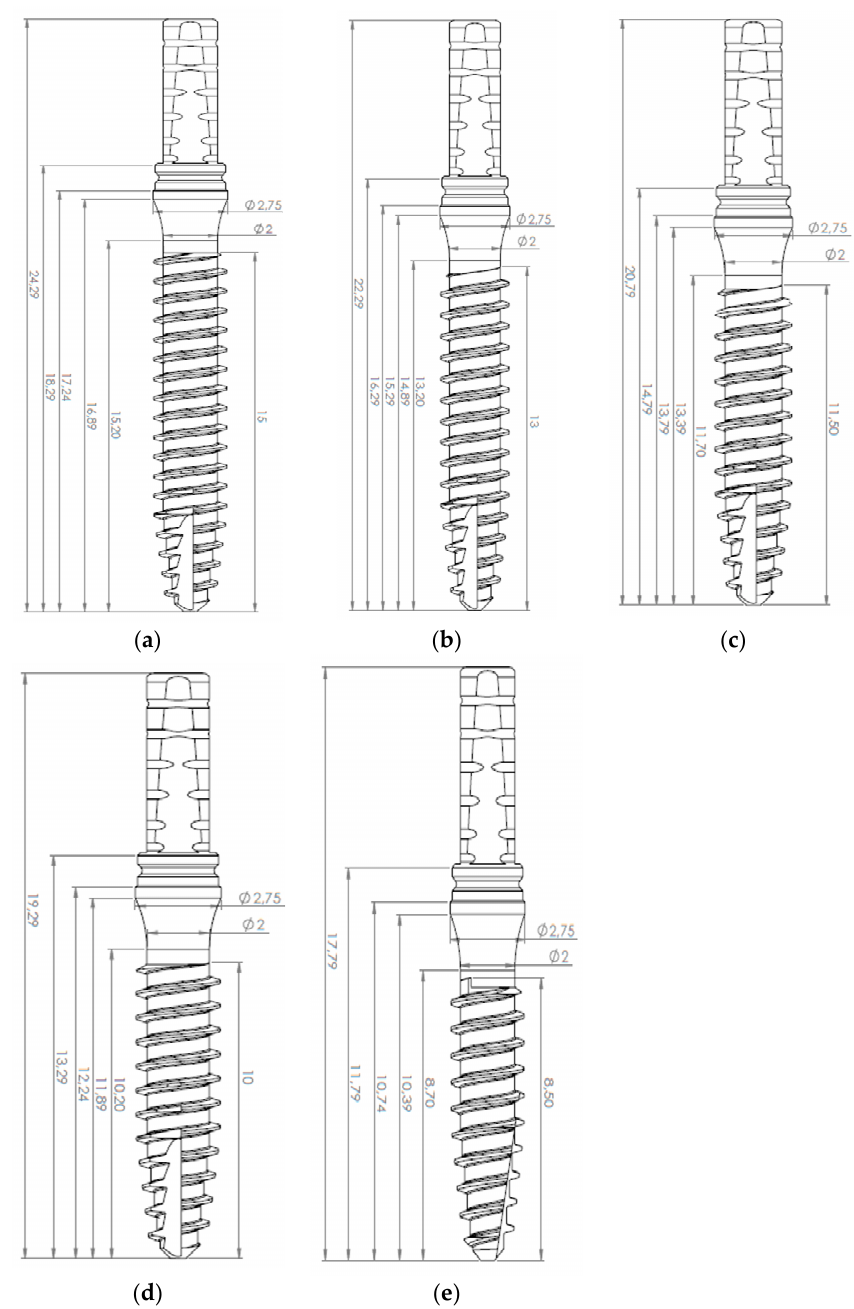
Figure 1. Temporary dental implants analyzed: ( a ) length 15 mm; ( b ) length 13 mm; ( c ) length 11.5 mm; ( d ) length 10 mm; ( e ) length 8.5 mm.